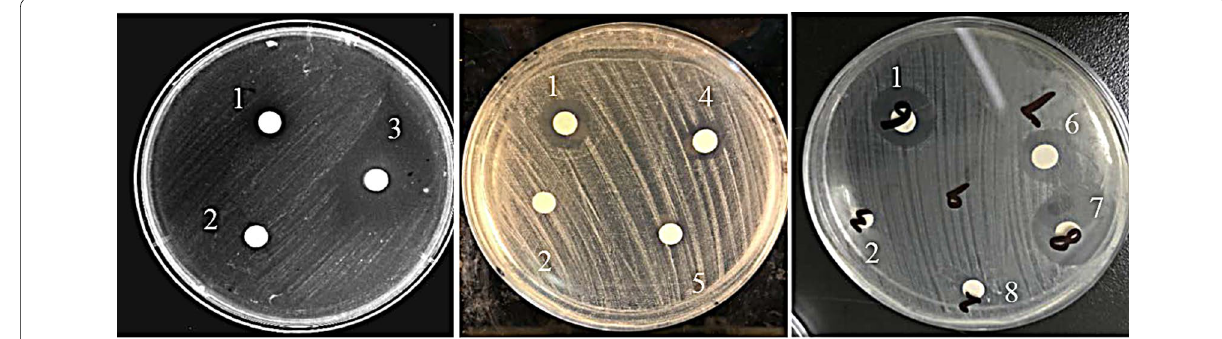
Fig. 4 Activity of various samples against Candida albicans by Filter paper method 1: Positive drug: Amphotericin B, 32 μg/mL; 2: Blank control: methanol solution; 3:the tenth fraction dissolved in methanol, 1 mg/mL; 4: Mojavensin A dipeptide dissolved in methanol, 512 μg/mL; 5: Cyclic (leucine-leucine) dipeptide dissolved in methanol, 512 μg/mL; 6: Mojavensin A: cyclic (leucine-leucine) dipeptide (leucine-leucine)